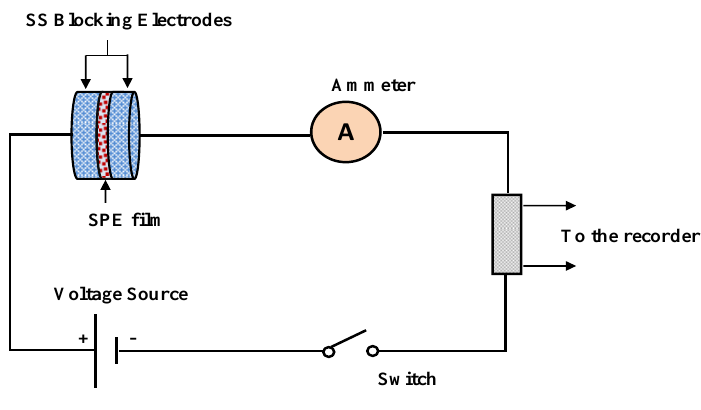
Figure 14. TNM measurement setup.